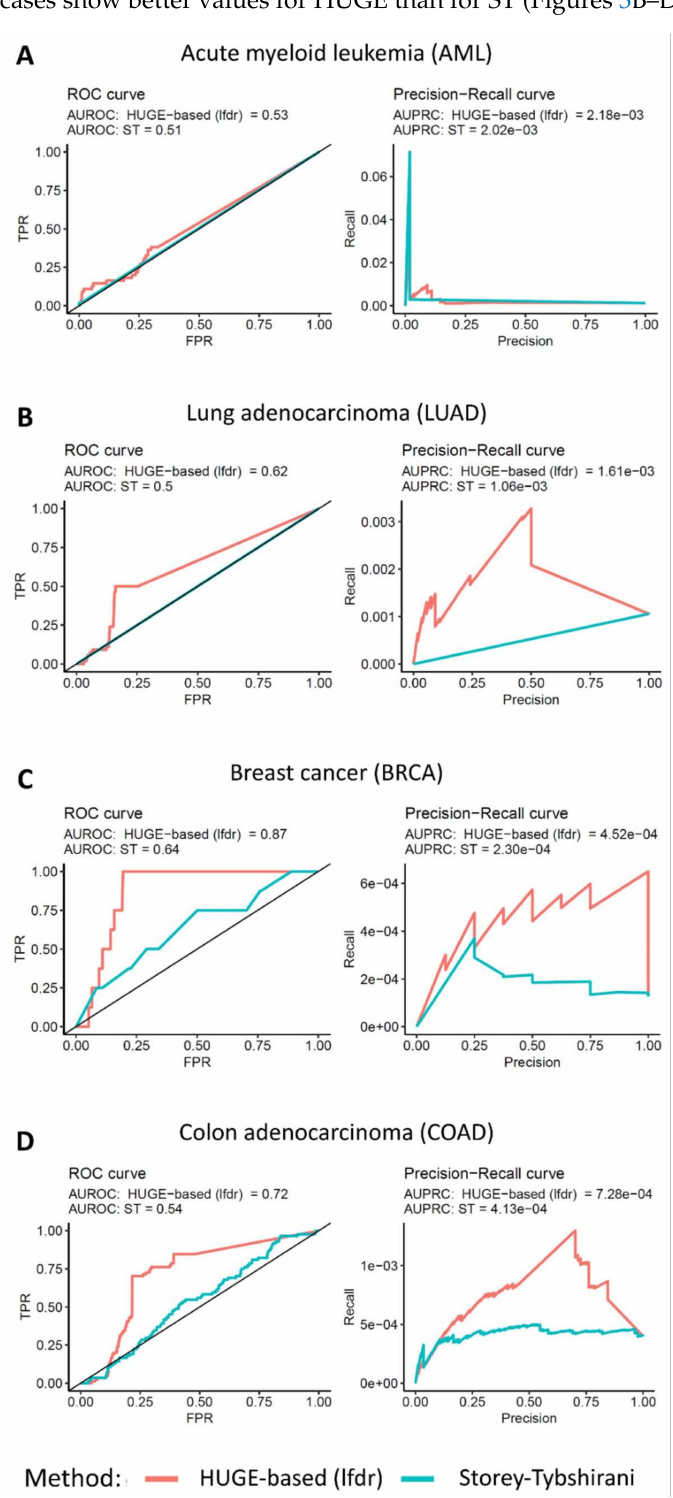
Figure 3. ROC and precision-recall curves of four tumor types. ( A ) Acute myeloid leukemia, ( B ) lung adenocarcinoma, ( C ) breast cancer and ( D ) colon adenocarcinoma. True positives were extracted from the knowledge base of the Variant Interpretation for Cancer Consortium [18,19].